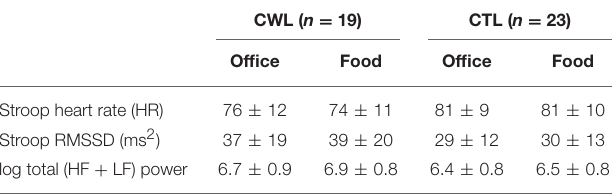
TABLE 4 | Cardiac ANS reactivity in clinical relevant weight loss (CWL; ≥ 5% of body mass) participants compared to women who had never weight cycled (CTL) during Food vs. Office Stroop